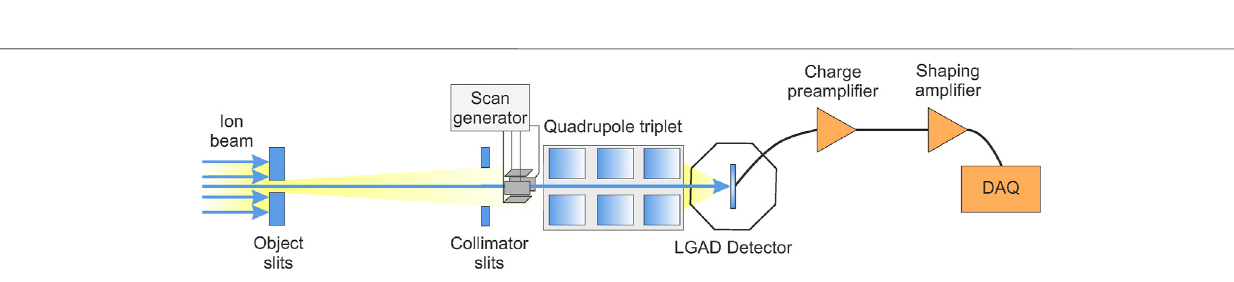
Frontiers in Physics |